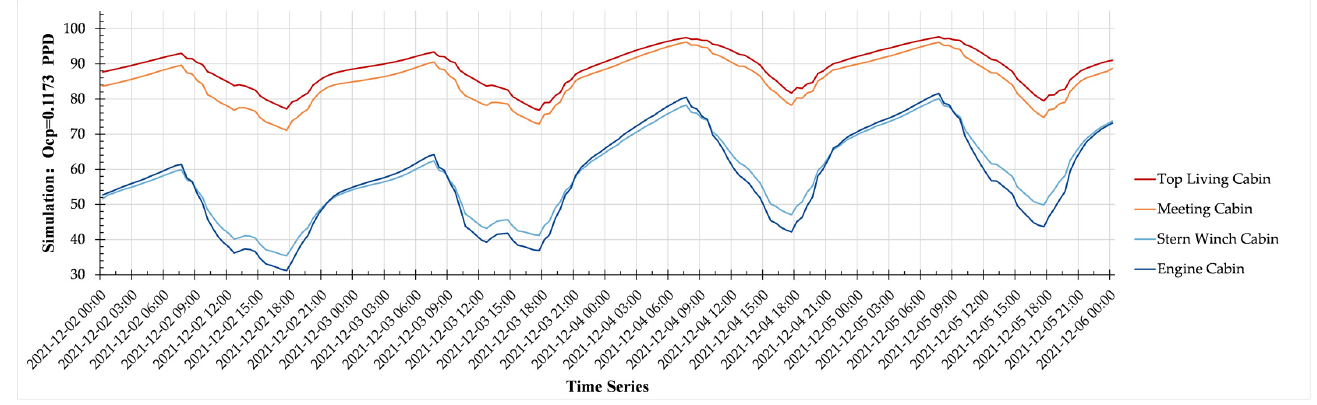
Figure 23. Simulation of PPD in the ship between 2 and 5 December 2021.